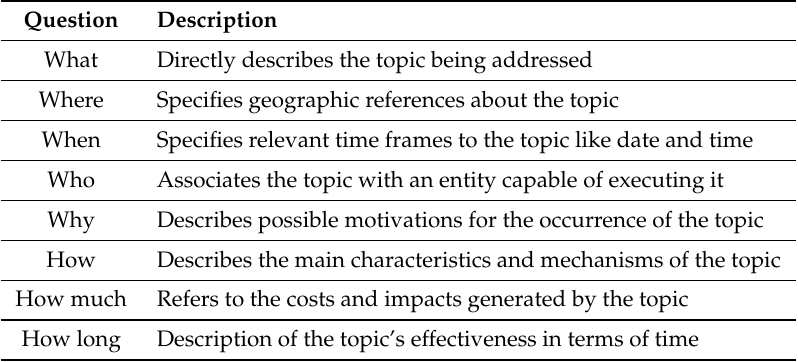
Table 1. Description of the 5W3H